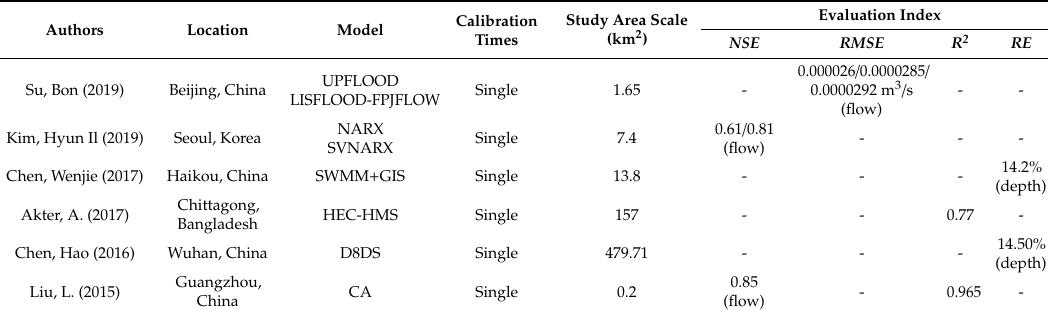
Table 2. Single rainfall statistics [1,28,39,53–55].